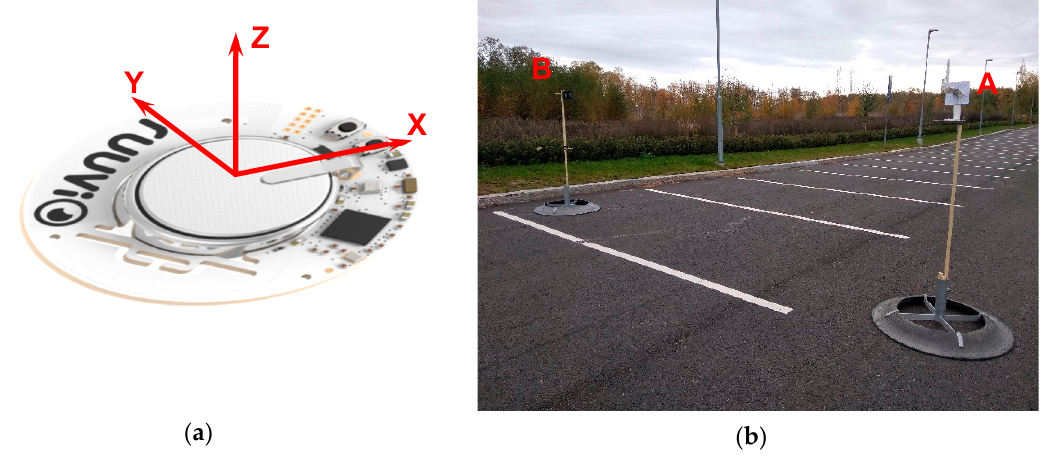
Figure 4. RuuviTag coordinate system ( a ). Setup of the propagation model and orientation experiment ( b ) with RuuviTag on a gimbal (A) and receiving station (B).